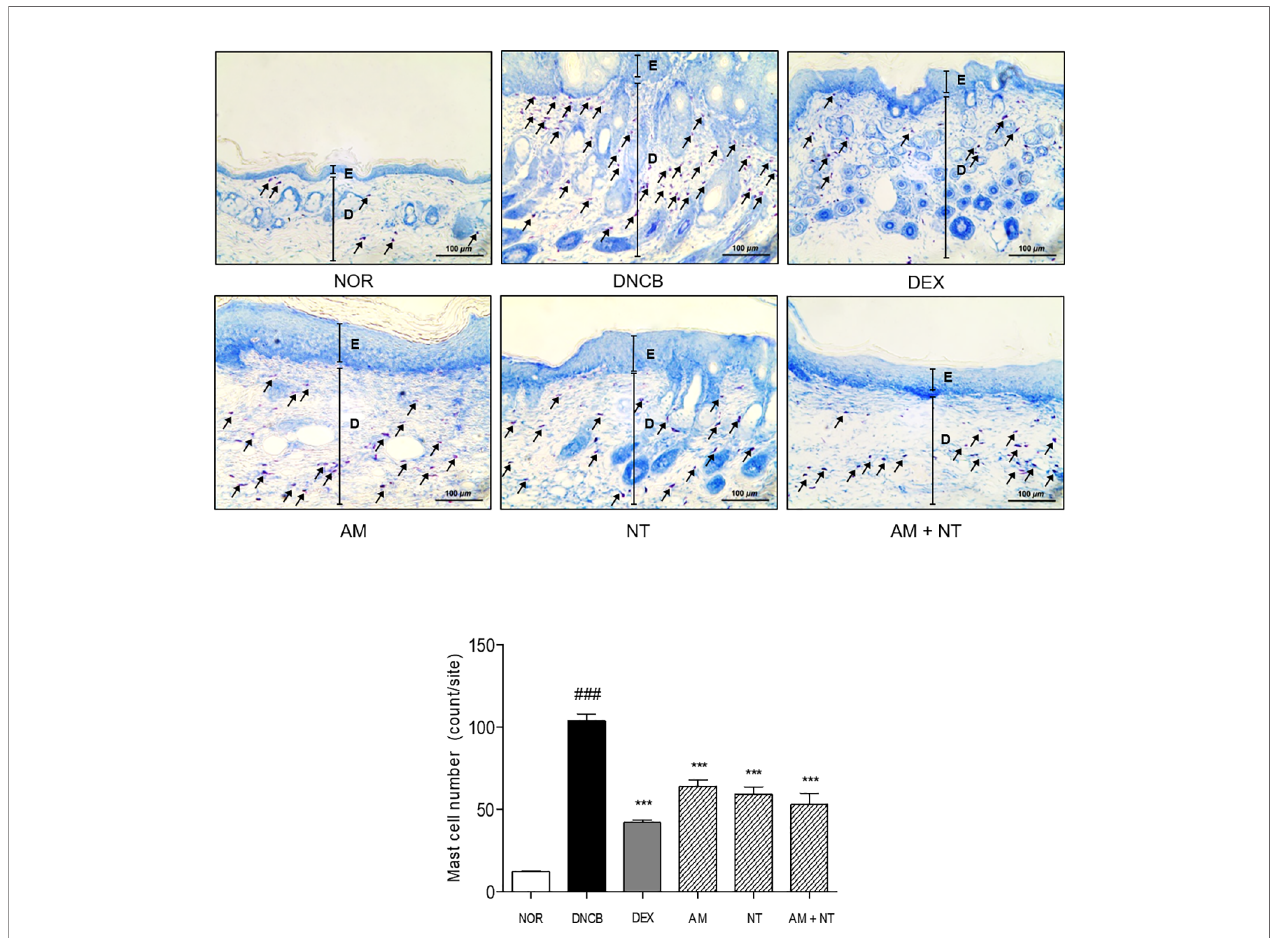
FIGURE 3 | Effects of AM, NT, and a mixture of AM and NT on mast cell degranulation with allergic contact dermatitis skin lesions. Mast cell in fi ltration in dorsal skin lesions were indicated by Toluidine blue staining. The magni fi cation is ×200. Data were presented as means ± S.E.M (n = 5). ### p < 0.001 vs. NOR; *** p < 0.001 vs. DNCB. Black lines indicate the layer of epidermis (E) and dermis (D). Arrows indicate the toluidine blue-stained mast